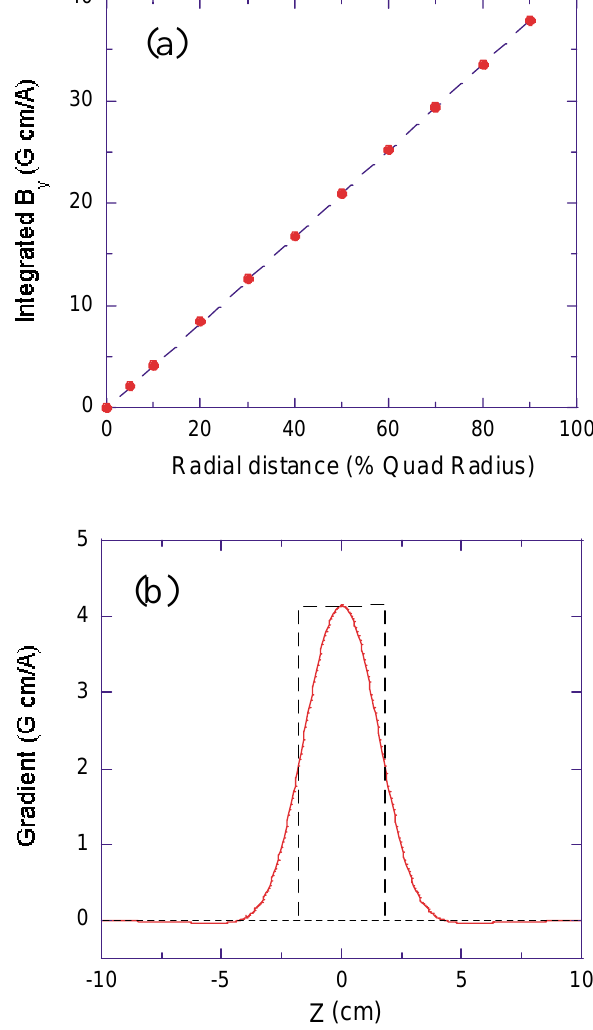
FIG. 4. (Color) Printed circuit quadrupole magnet. (a) Radial variation of axially integrated transverse field, per amp, at u (cid:1) 0 ± , and (b) on-axis gradient profile, per amp. The broken lines in (b) indicate the effective hardtop